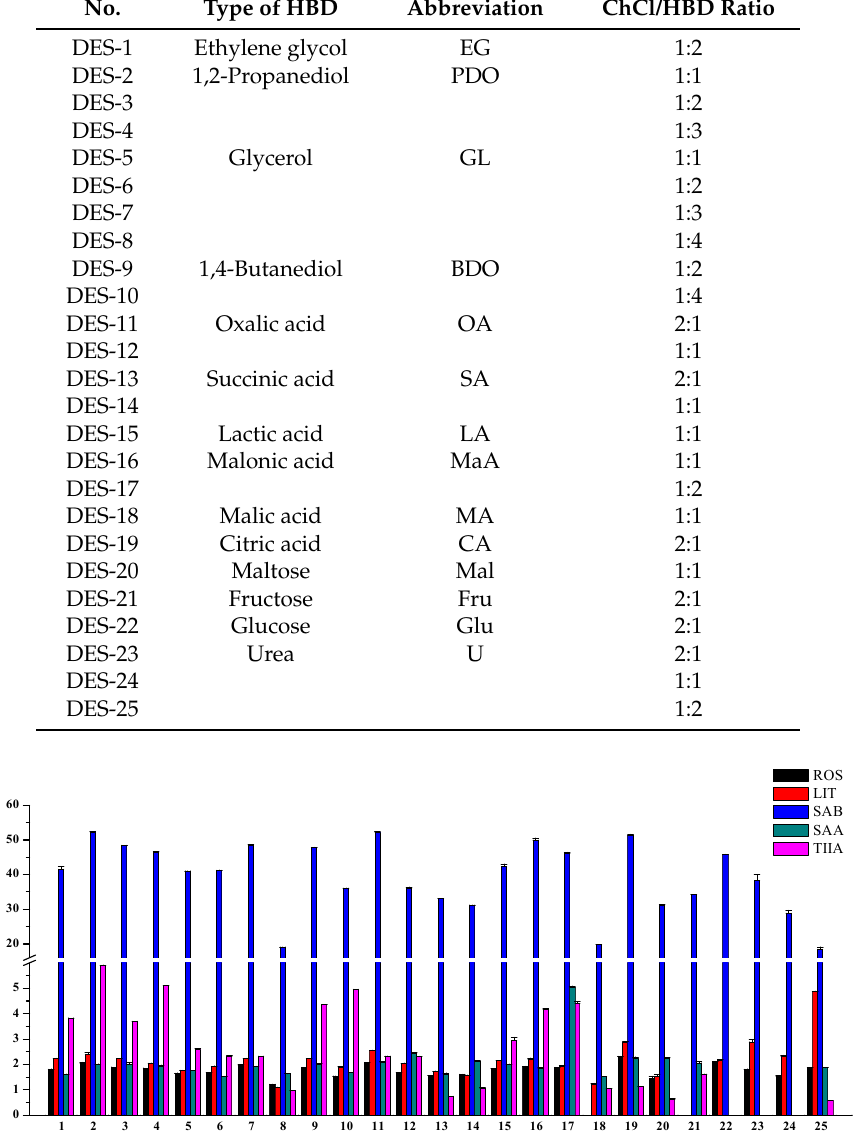
Table 1. Different composition of DESs applied in this work.